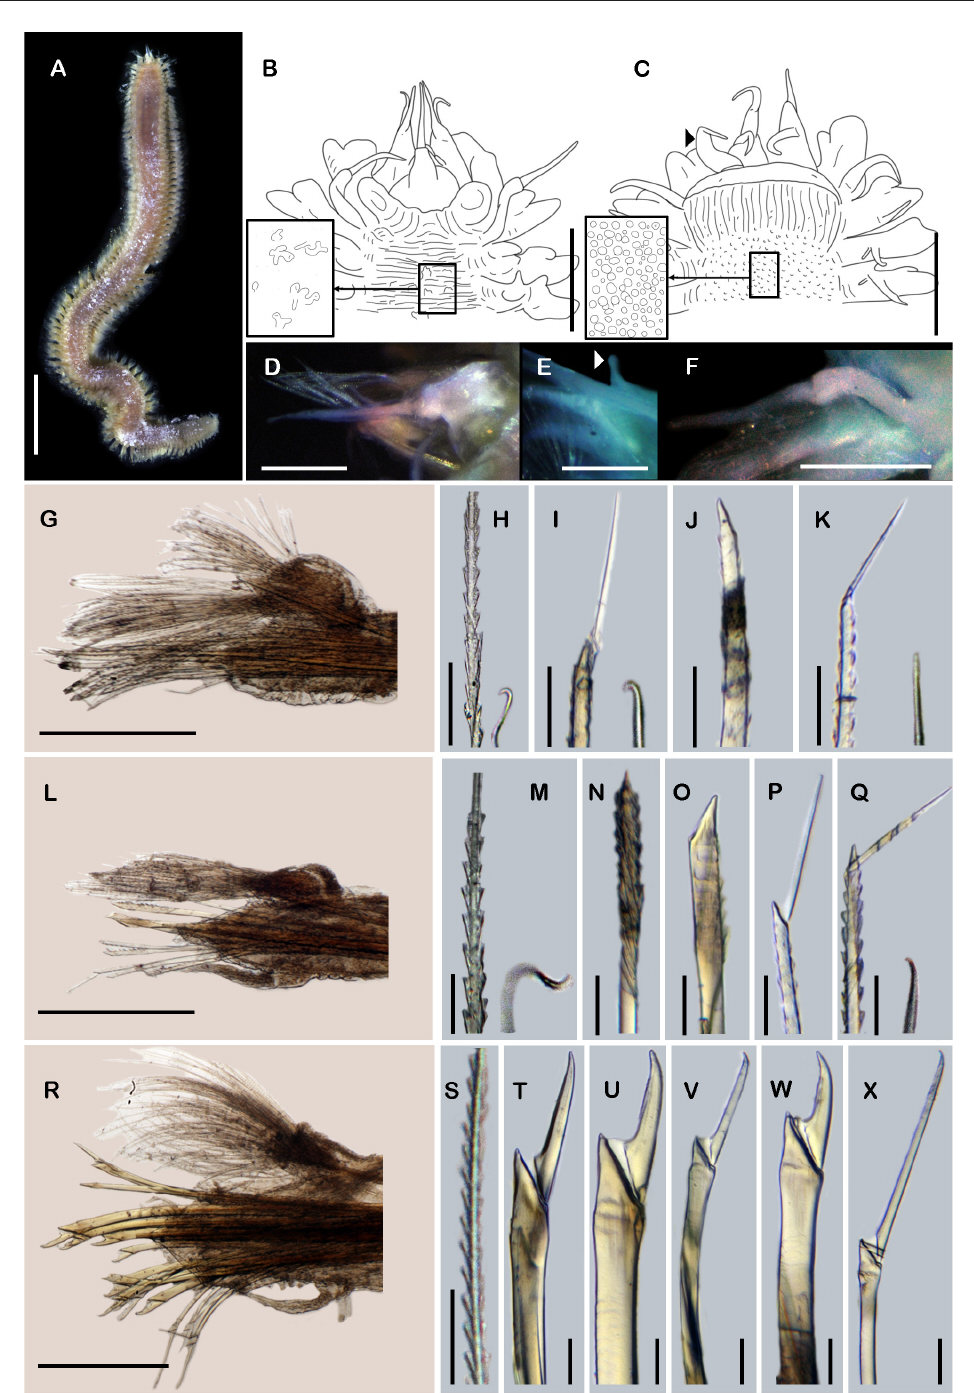
Fig. 13. Pelogenia brevipalpata sp. nov., holotype (ECOSUR 289). A . Complete worm, dorsal view. B . Anterior end, dorsal view (insert: dorsal papillae). C . Anterior end, ventral view, arrowhead indicates palp (insert: ventral papillae). D . Median antenna. E . Lateral antenna. F . Right dorsal cirrus from segment III. G . Right parapodium from segment II. H . Notochaeta from same. I . Unit A. J . Unit B. K . Units C and D. L . Right parapodium from segment III. M . Notochaeta from same. N . Unit A. O . Unit B. P . Unit C. Q . Unit D. R . Right parapodium from segment 28. S . Notochaeta from same. T . Unit A. U . Unit B. V . Unit C. W . Subunit 1. X . Unit D. Scale bars: A = 5 mm; B–C = 1 mm; D–G, L, R = 500 μm; H, M, S = 40 μm; I–K, N–Q, T–X =